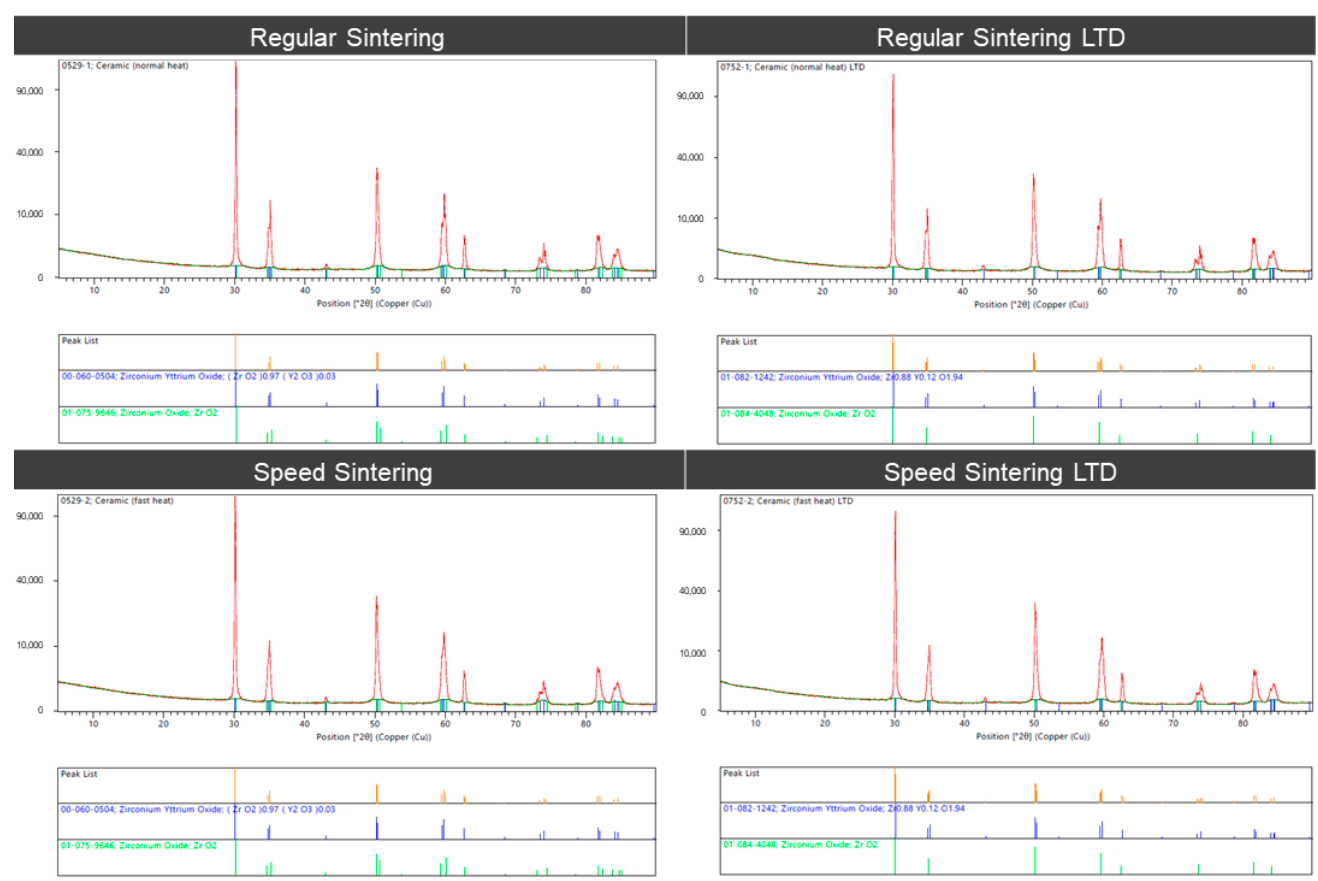
Figure 7. X-ray diffraction (XRD) analysis of the zirconia specimens for the regular sintering and speed sintering with and without low-temperature degradation (LTD).